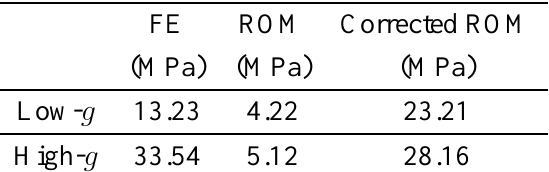
Table 2. Test-induced maximum values of the principal stress σ FE results, ROM outcomes, and ROM results corrected through the model-specific stress intensity factor (see Figure